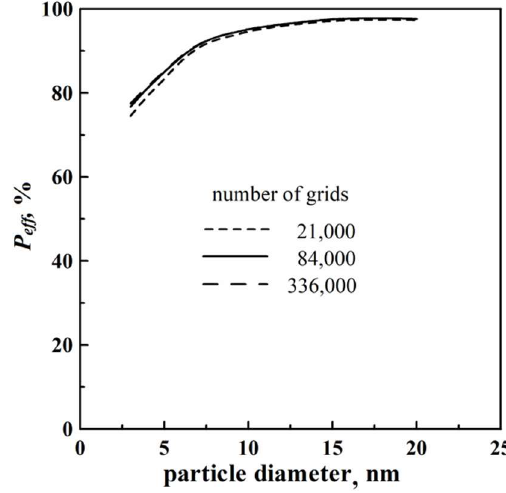
Figure 3. Penetration efficiency for different grid sizes of the hollow tapered cylinder without conical column at the flow rate of 2 L/min.